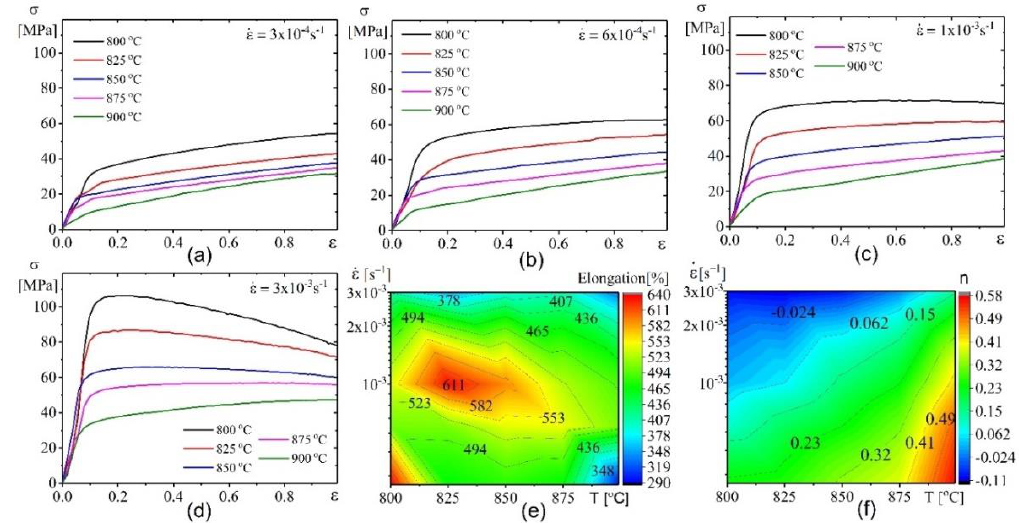
Figure 3. Stress dependence on strain at various temperatures and various strain rates: ( a ) 4 × 10 −4 s −1 , ( b ) 6 × 10 −4 s −1 , ( c )1 × 10 −3 s −1 , ( d ) 3 × 10 −3 s −1 , ( e ) elongation-to-failure, and ( f ) strain hardening coefficient (n).